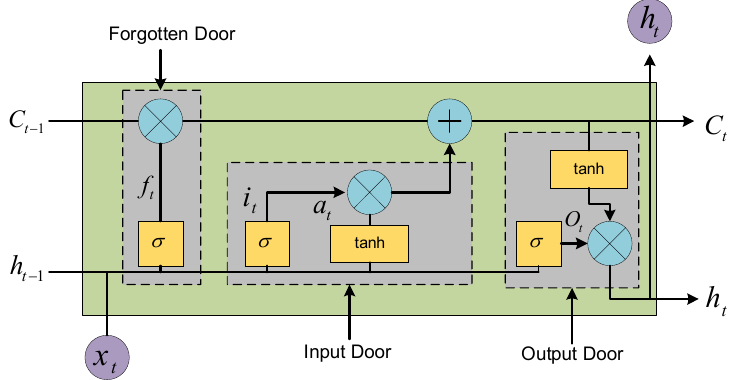
Figure 4. The LSTM structure diagram.